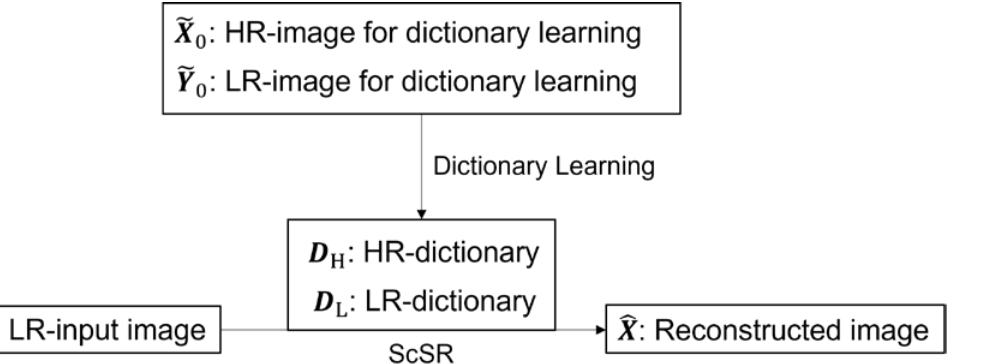
Figure 1. Flowchart of the outline of ScSR. HR and LR indicate high-resolution and low-resolution, respectively.